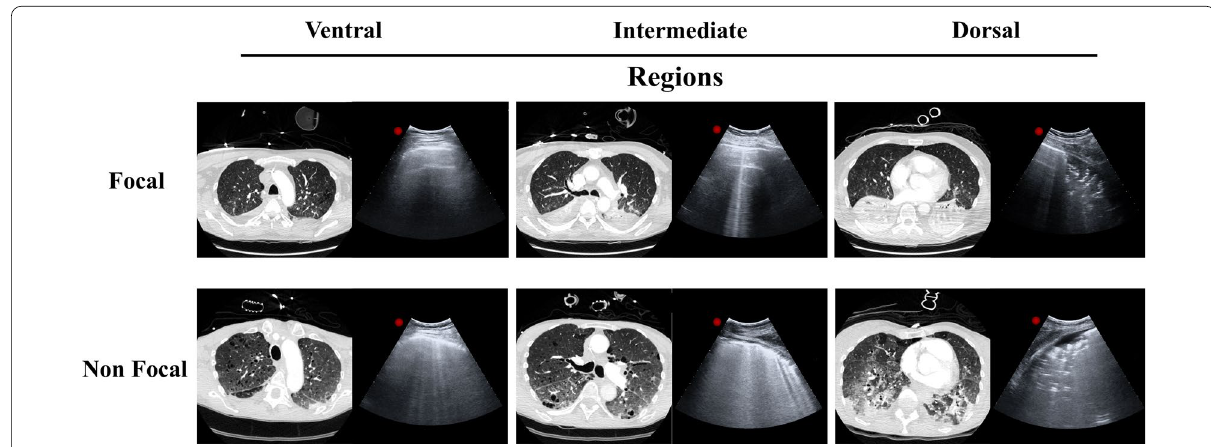
Fig. 2 Representative lung TC images and their corresponding LUS images in ventral, intermediate and dorsal lung regions in focal and non-focal ARDS